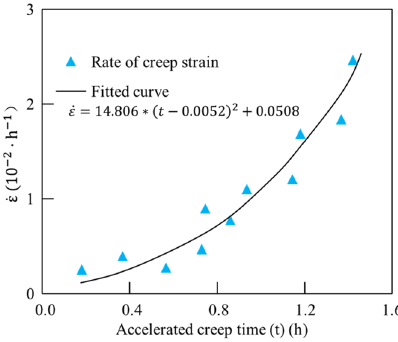
Figure 8. Variation trend of creep rate in accelerated creep